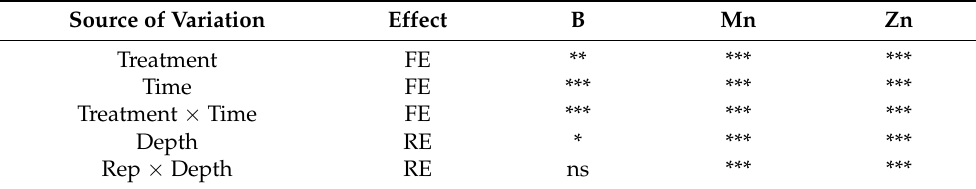
Table 3. Factor effects and their significance level for B, Mn, and Zn.